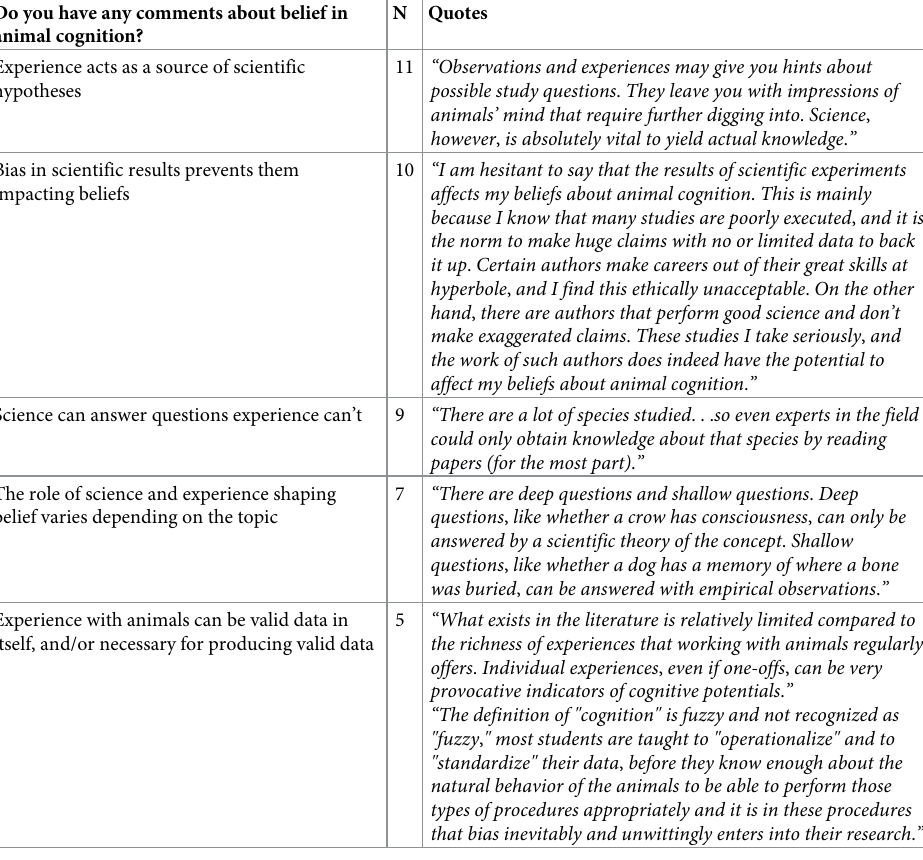
Table 8. Animal cognition researchers’ beliefs about the role of science and day-to-day experience in shaping their beliefs about the cognition of animals. Do you have any comments about belief in animal